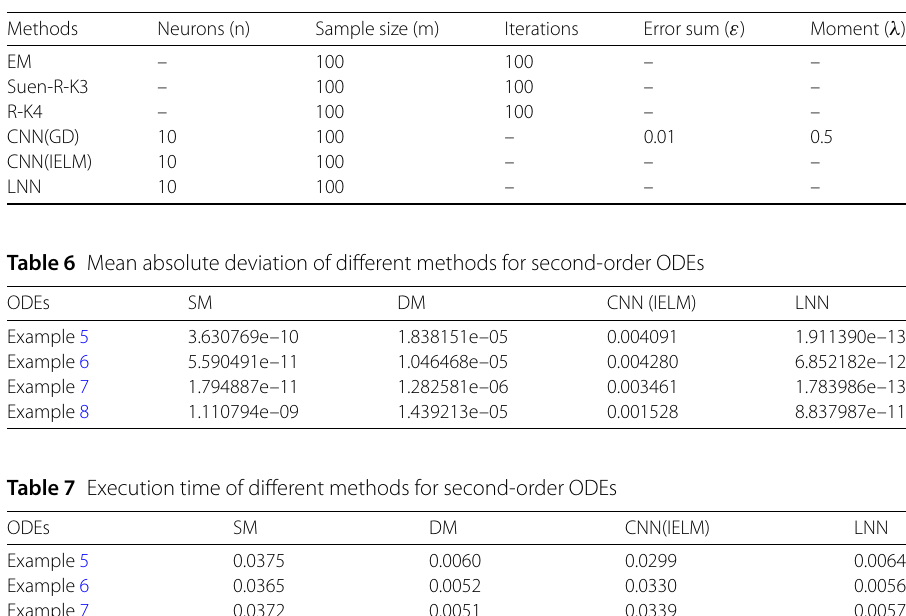
Table 5 Parameters of different methods Methods